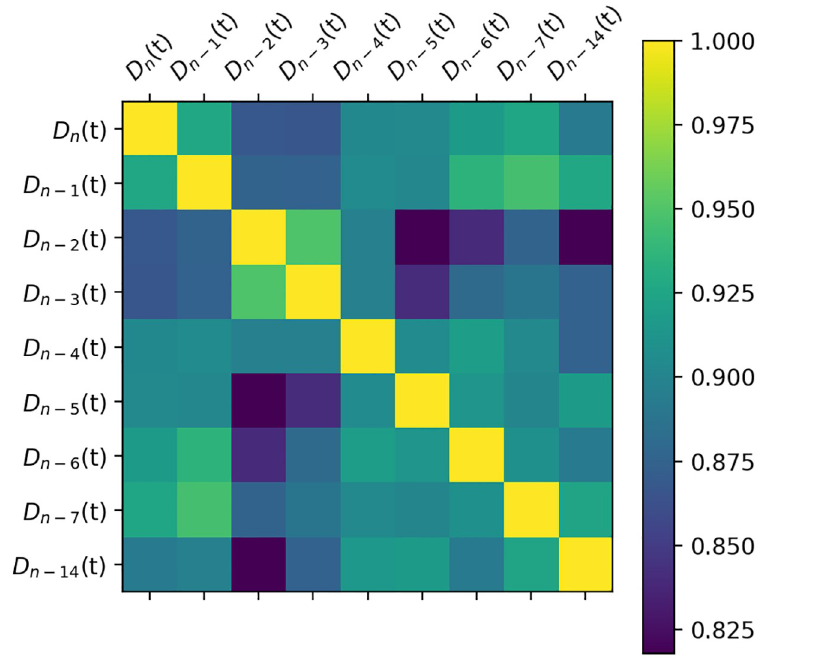
Fig 9. Taxi demand correlation analysis of the same period on different working